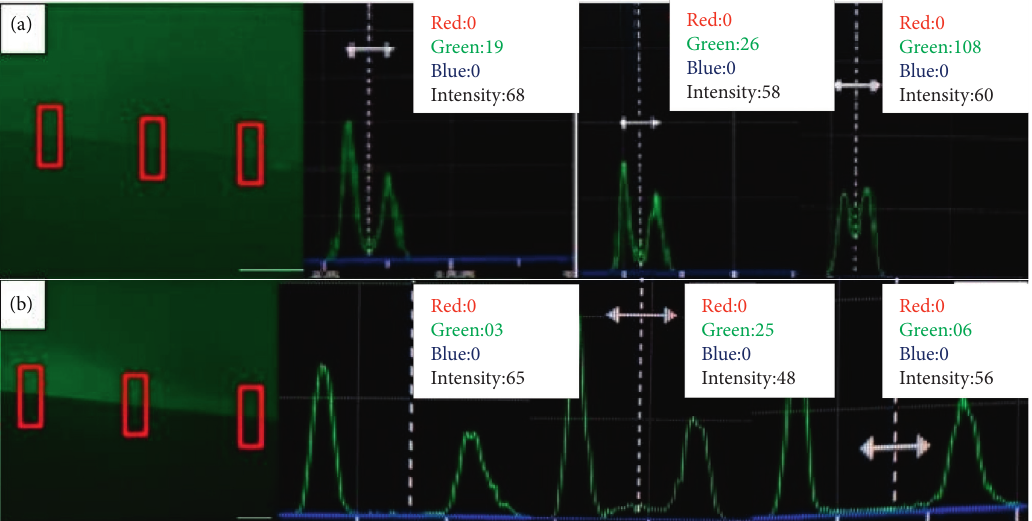
Figure 5: Histograms of MMP activity: (a) chlorhexidine digluconate with Clearfil ™ and (b) chlorhexidine with Adper Single Bond 2 ™ .